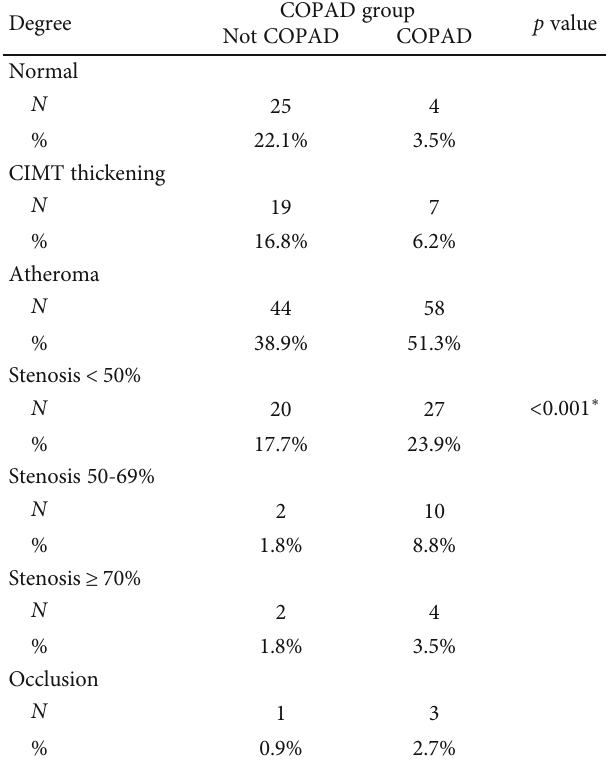
Table 1: Analysis of the association between the presence of PAD and the variables (risk factors/diseases).